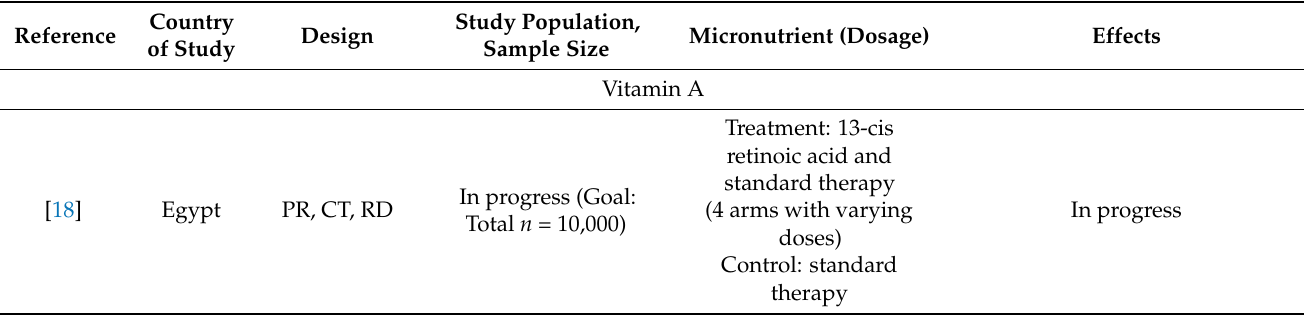
Table 1. Effects of nutrient supplementation on